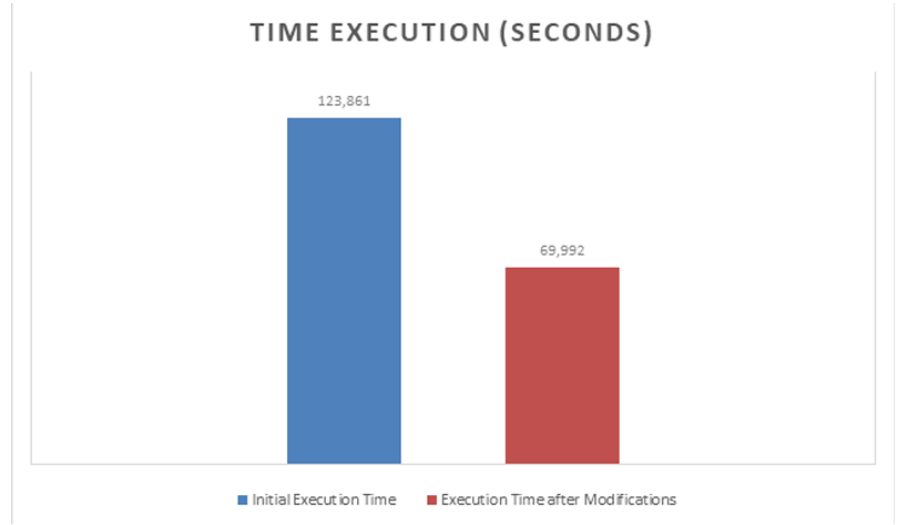
Figure 6. Kalign time execution